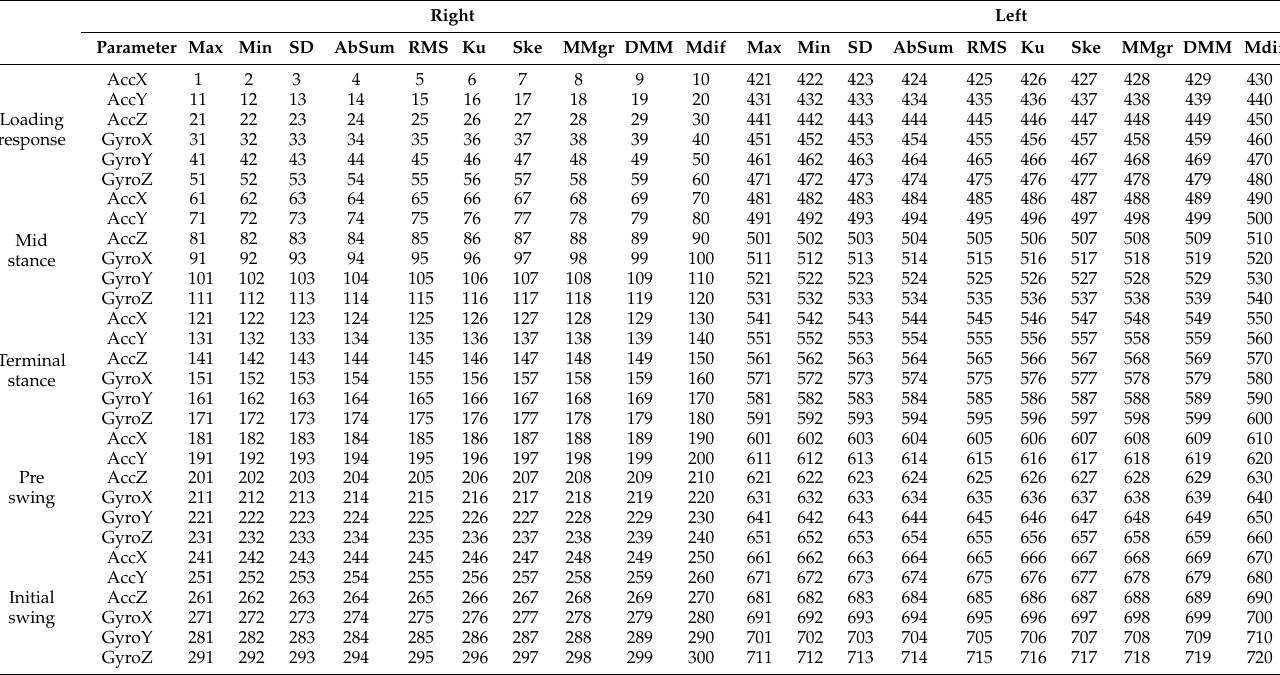
Table 10. Seven-phase descriptive statistical